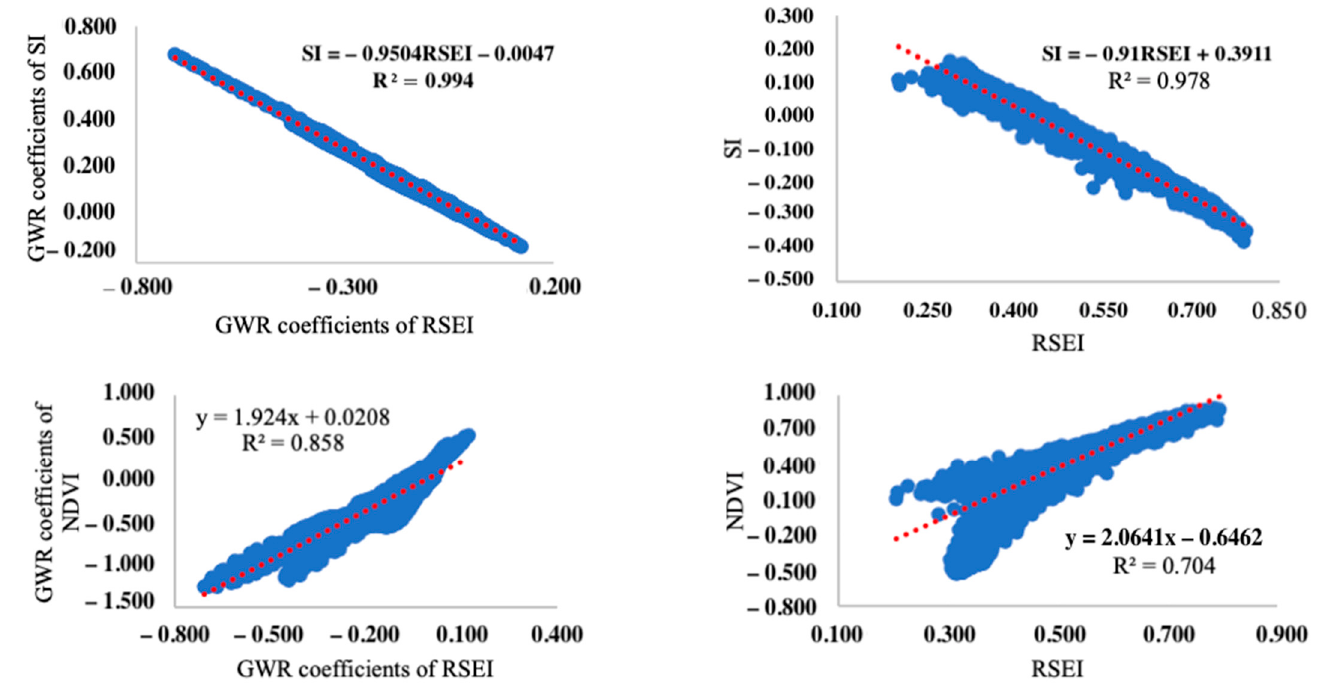
Figure 5. Scatter plots of coefficients of remote-sensing-based ecological index (RSEI), soil index (SI), and normalized difference vegetation index (NDVI).